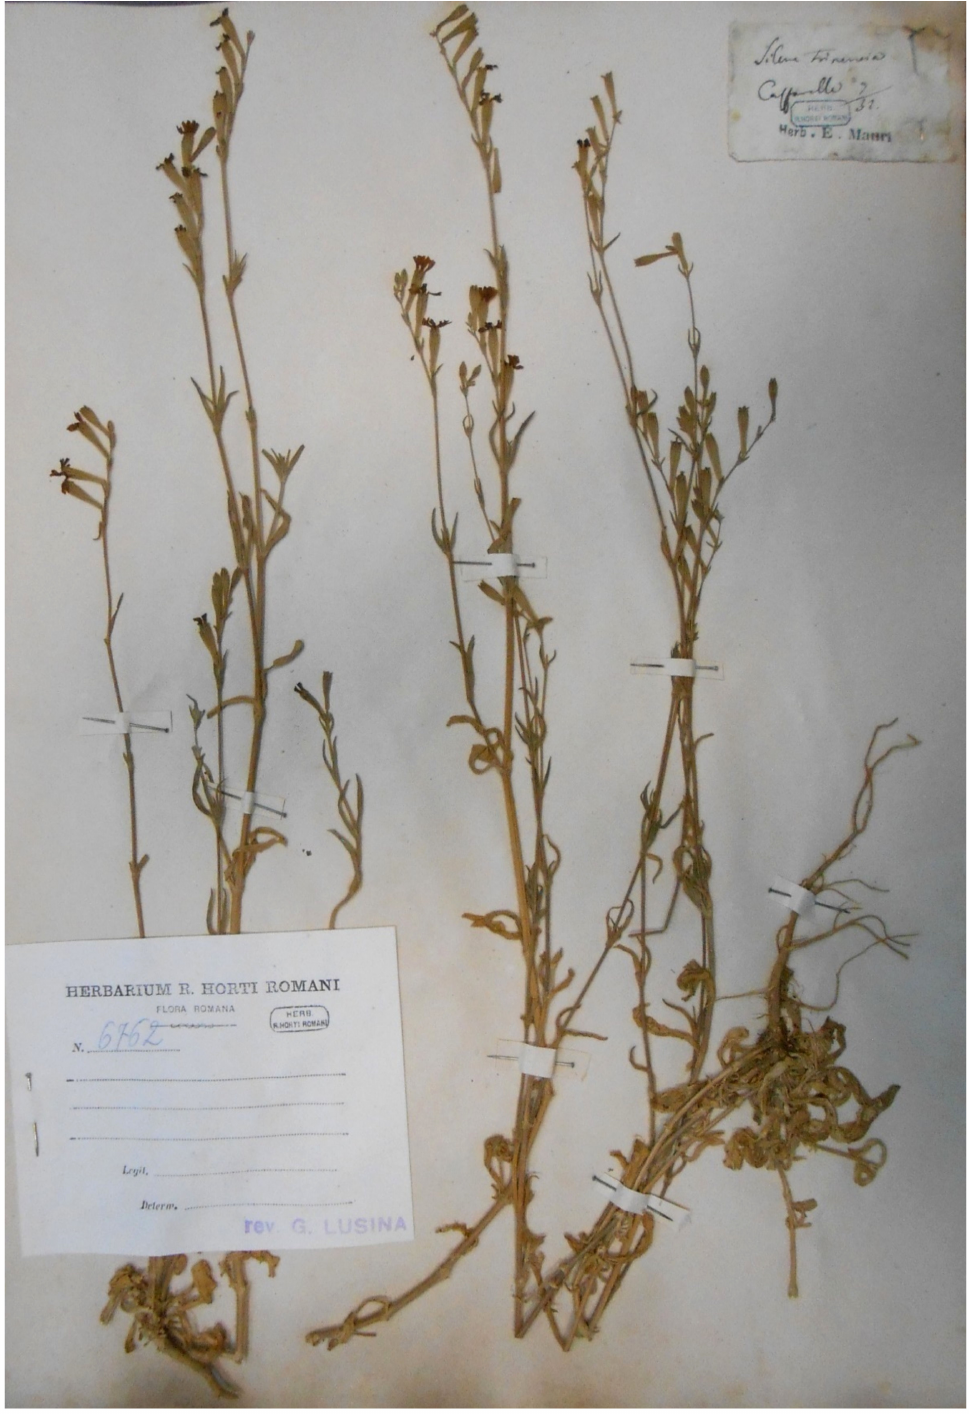
Figure 73. Epitype of Silene trinervia (RO-Herbarium Romano no.